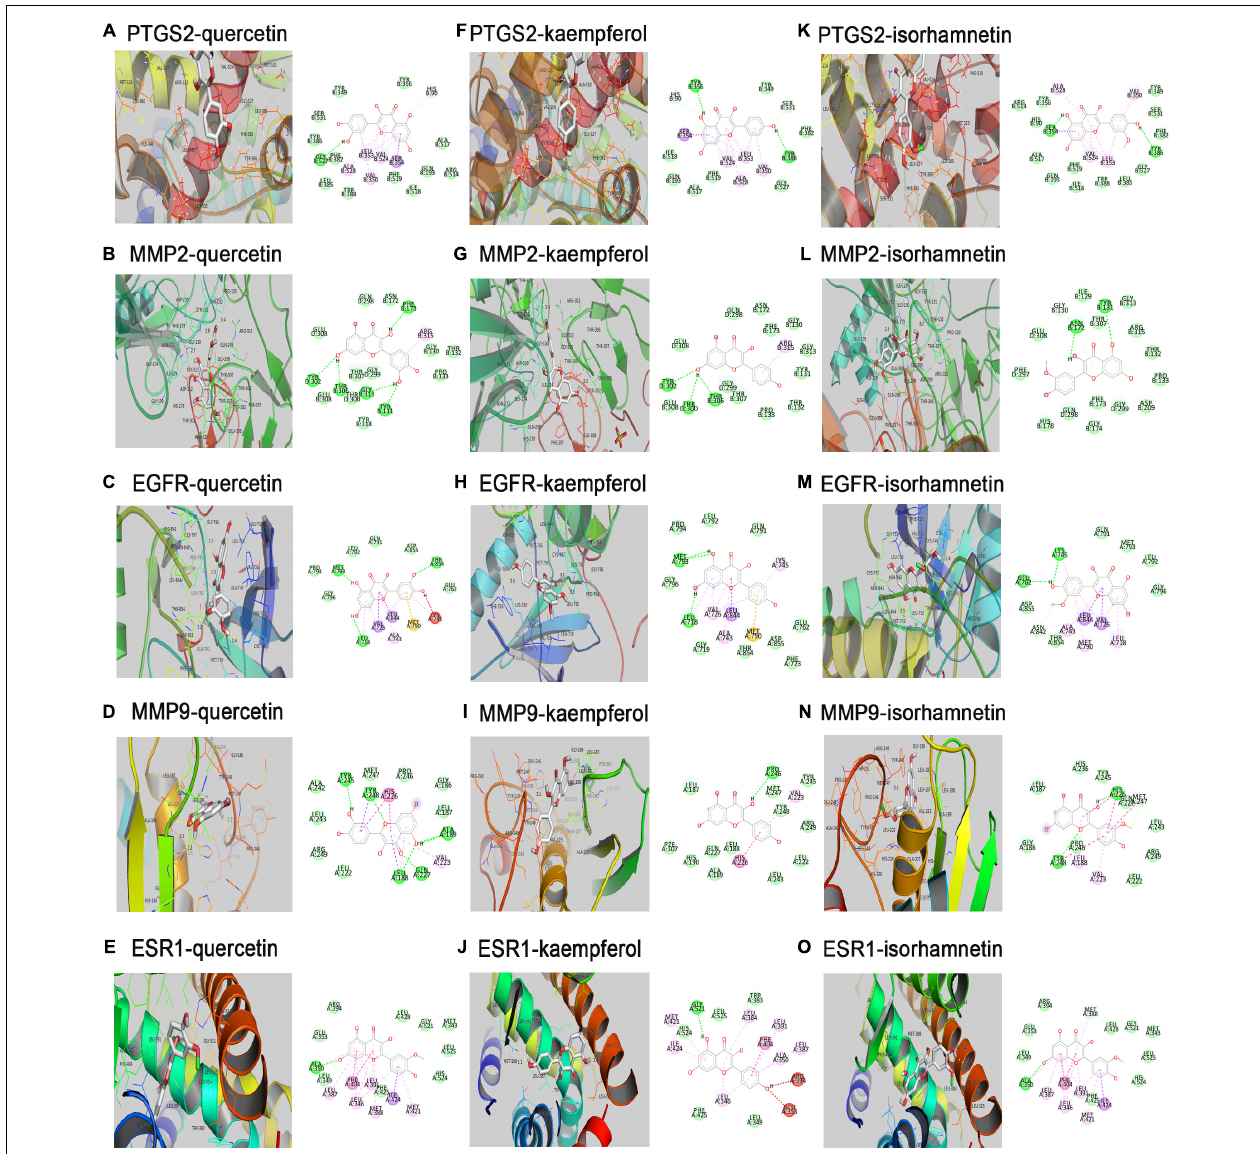
FIGURE 6 | Molecular docking models of effective compounds binding to potential targets. (A–E) Quercetin interacting with PTGS2, MMP2, EGFR, MMP9, ESR1, respectively. (F–J) Kaempferol interacting with PTGS2, MMP2, EGFR, MMP9, ESR1, respectively. (K–O) Isorhamnetin interacting with PTGS2, MMP2, EGFR, MMP9, ESR1,